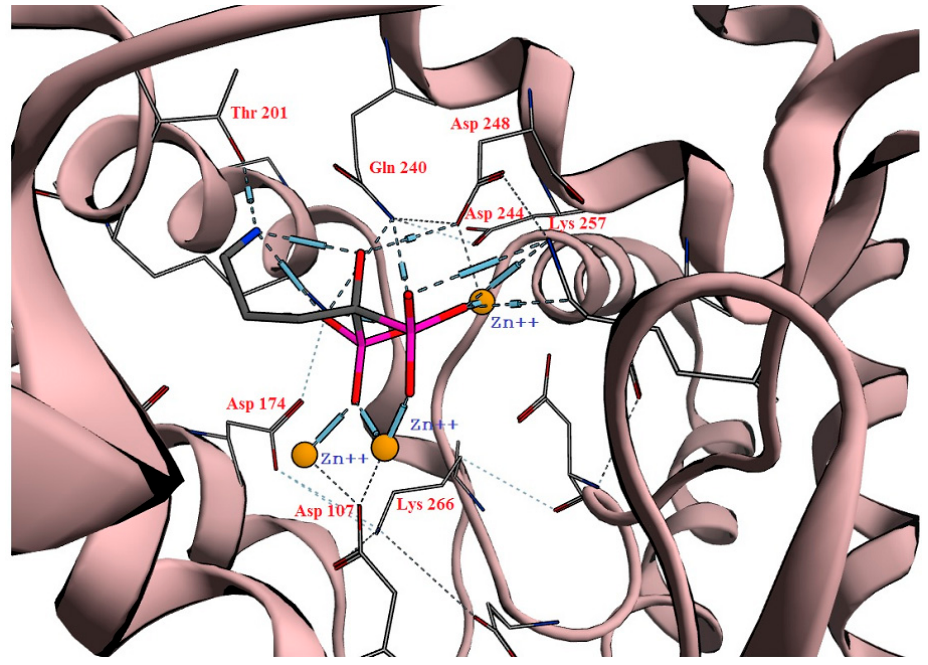
Figure 3. The best orientation pose of alendronate in the active site.